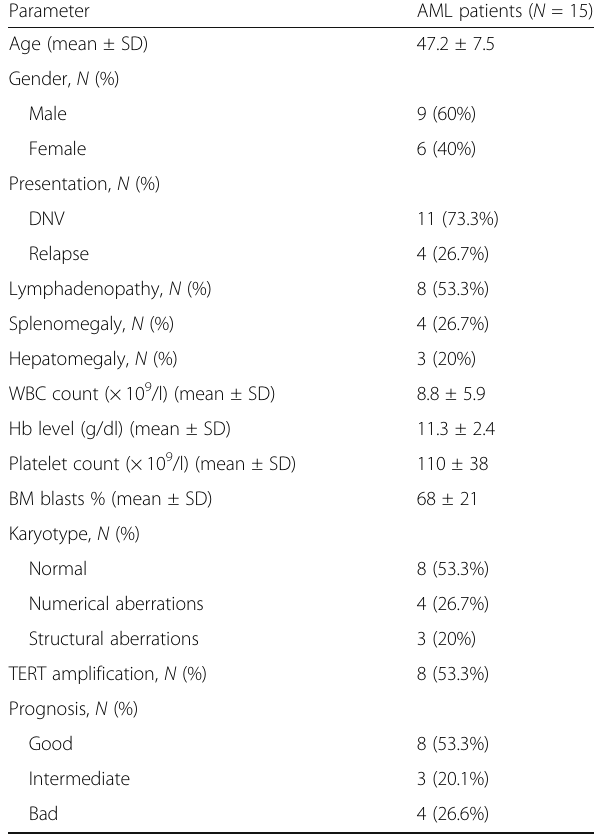
Table 5 Descriptive data of acute myeloid leukemia